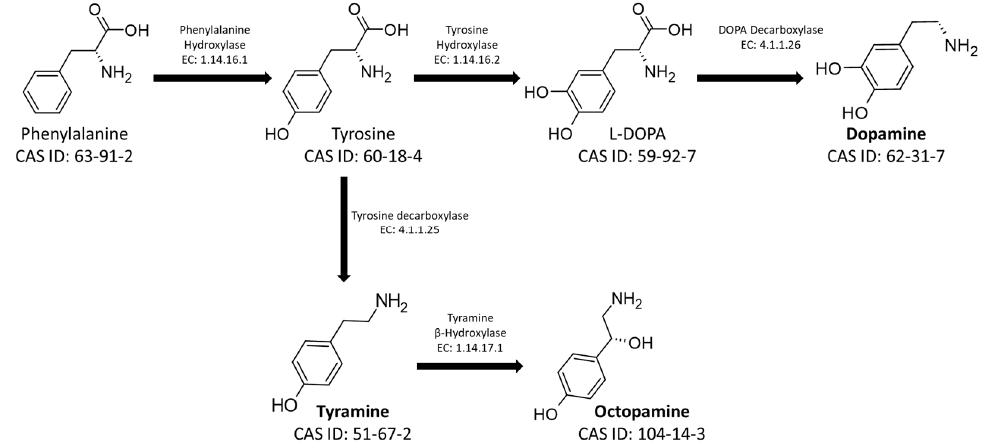
Figure 1. Metabolic pathways for the synthesis of the biogenic amines Tyramine, Octopamine, L- DOPA, and Dopamine. The figure shows the CAS-IDs of the molecules along with the EC numbers of the enzymes involved in the biosynthetic